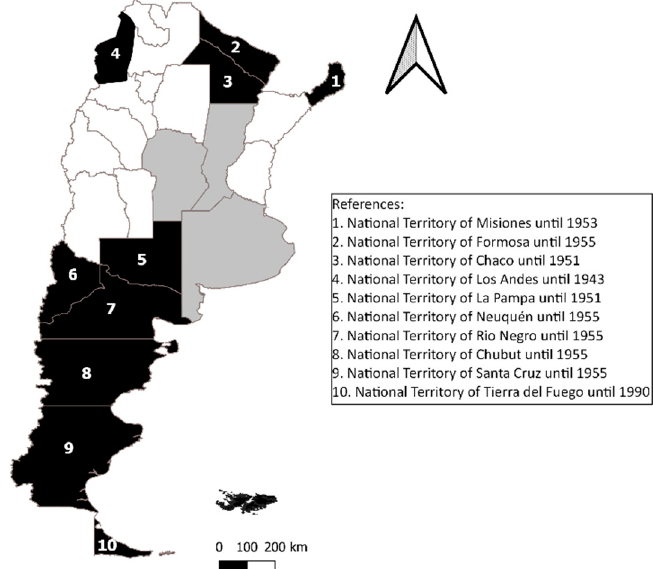
Figure 1. Argentinean map. Historical Central Region in grey, historical provinces in white and National Territories in black. In the references, it is mentioned the year of recognition as province.